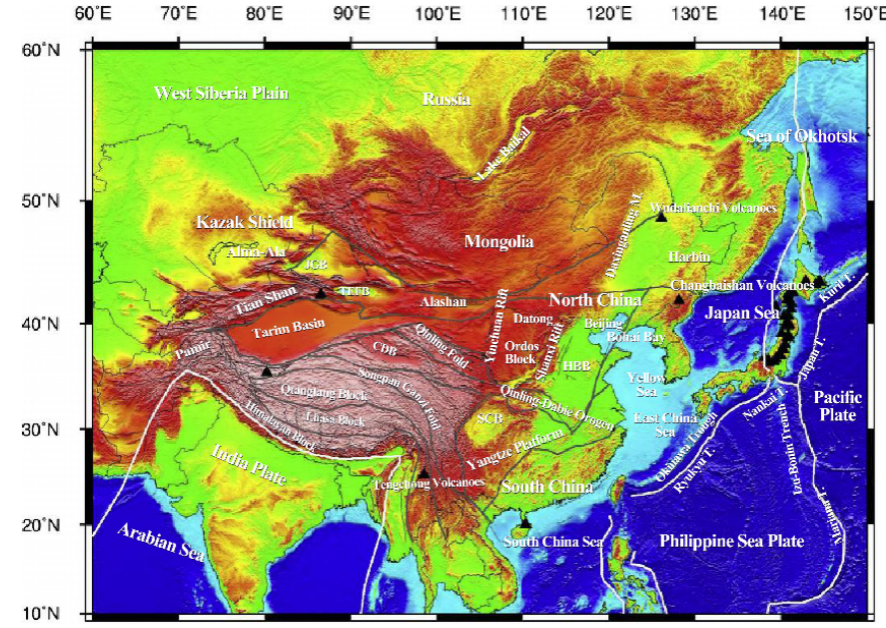
Figure 3. The geological setting of China (modified from [99]).